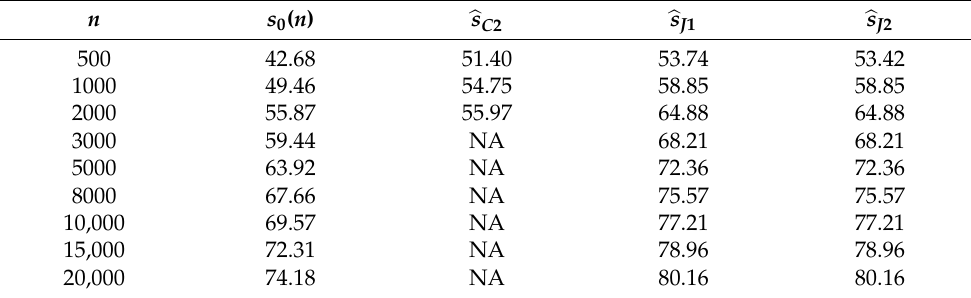
Table 2. Estimates for the Number of Shared Species (Numbers of species in two populations are s 1 = 100 & s 1 = 100, the number of shared species is s 0 = 80, and species proportions are from Geom(0.99) and Geom(0.9); J 1 & J 2: 1st & 2nd Jackknife estimates, C 2: Chao’s estimate, s 0 ( n ): number of observed shared species).